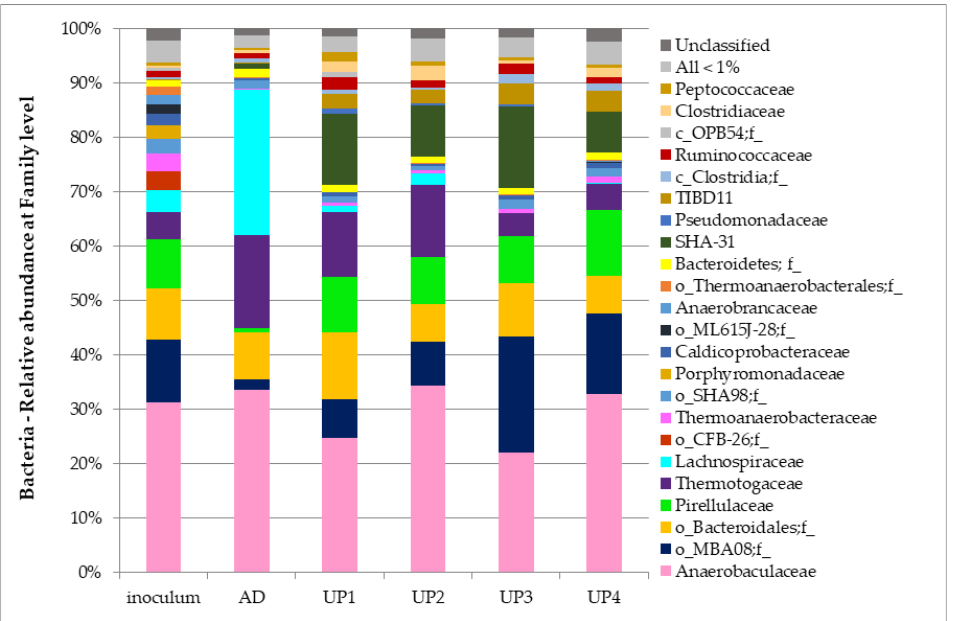
Figure 4. Relative abundances of bacteria community at family level in the sludge used as inoculum, at the end of AD and UP1, UP2, UP3, UP4 phases. Communities with a relative abundance ≥1% (in at least one sample) are reported.